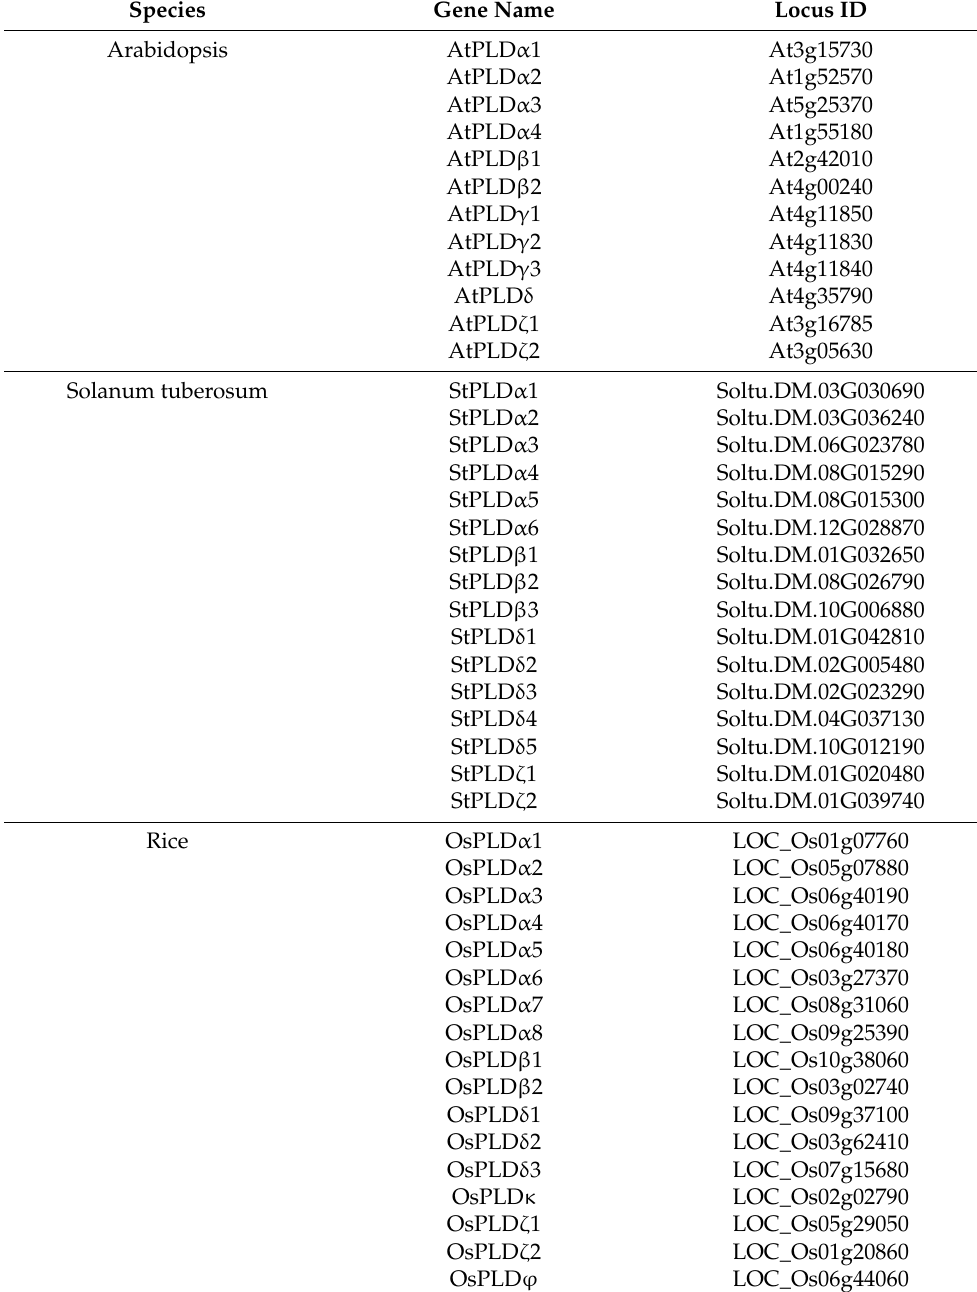
Table A2. Protein sequences used in the phylogenetic relationship